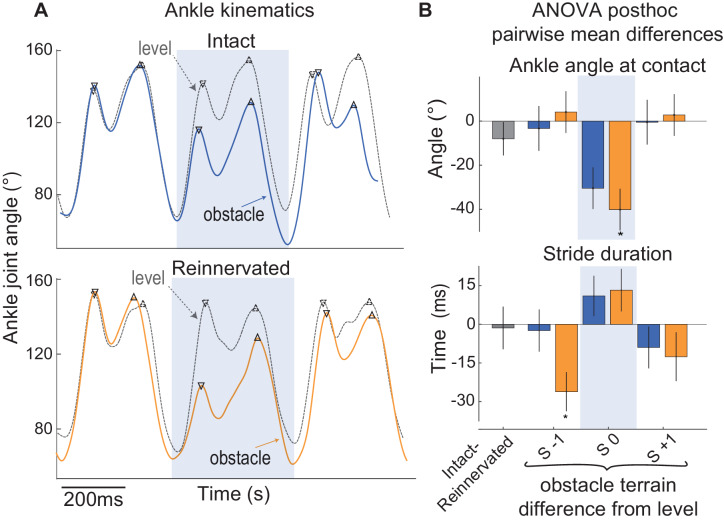
Ankle kinematics in guinea fowl with intact and reinnervated lateral gastrocnemius (LG).(A) Example ankle joint angle trajectories for a bird with intact LG (blue, top) and a bird with reinnervated LG (orange, below), running in obstacle terrain (solid lines) with level terrain (grey dashed lines). (B) Pairwise mean differences (mean ±95% ci) between intact and reinnervated treatment cohorts (grey), and obstacle stride categories compared to level terrain within each treatment cohort (intact: blue, reinnervated: orange). In obstacle strides (S 0, shaded box), the ankle is more flexed at foot contact in reinnervated compared to intact birds. Reinnervated birds show a shorter stride period in S −1, preceding the obstacle encounter, suggesting increased anticipatory preparation. (See Figure 8—source data 1 for statistical results on ankle angle at the time of foot contact).Figure 8—source data 1.ANOVA results for ankle angle at time of foot contact.F-statistics, p-values and posthoc pairwise comparisons for linear mixed effect model ANOVA with fixed effects of treatment cohort (treatment: intact, reinnervated) and stride category (stride ID) and the interaction treatment x stride ID. Posthoc pairwise mean differences (mean ±95% ci) are shown between intact and reinnervated treatment cohorts (left), and between obstacle stride categories compared to level stride means, within treatment cohorts (intact/reinnervated).